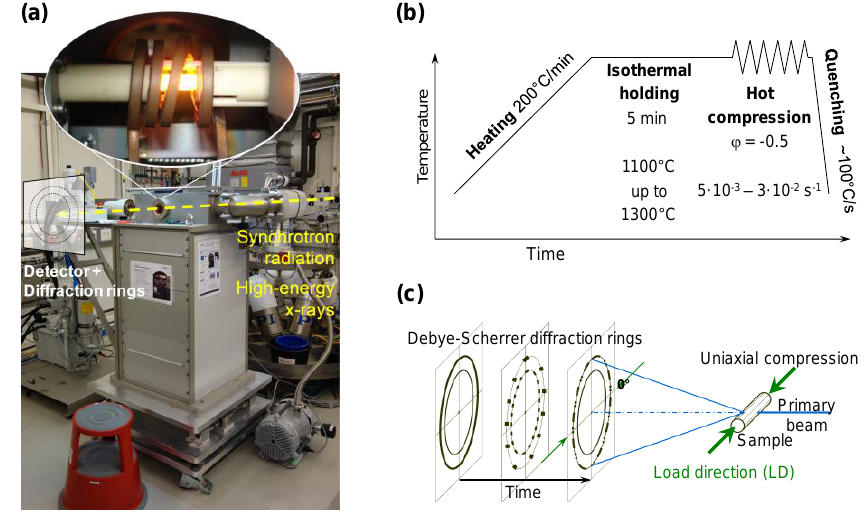
Figure 1. ( a ) The deformation dilatometer mounted in the HEMS beamline. The insert shows the interior of the measurement chamber with a heated sample just before hot forming. Schematic diagrams showing; ( b ) the compression experiments and processing parameters; and ( c ) the diffraction